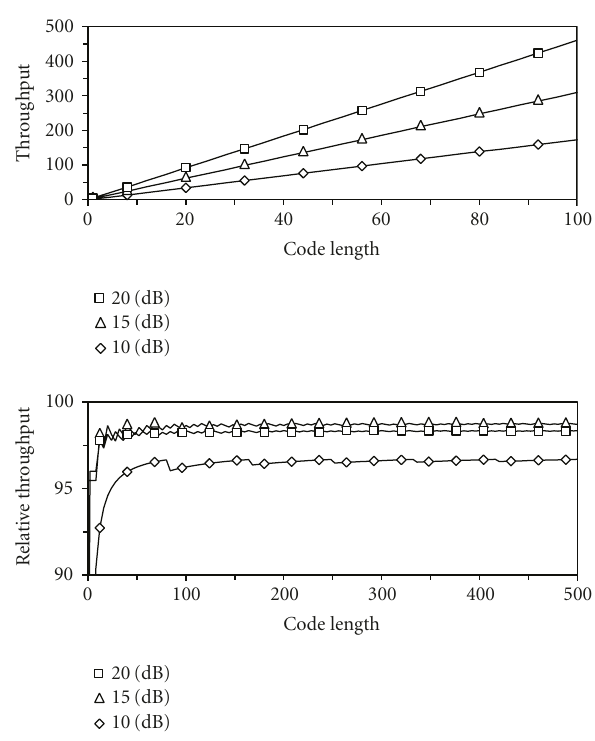
Figure 3: Throughput R p in bit per SS-OFDM symbol and relative throughput R p / R p in percent versus code length L t = L , for 1 sub- carrier, 3 received SNR { 10,15,20 } dB and Γ =